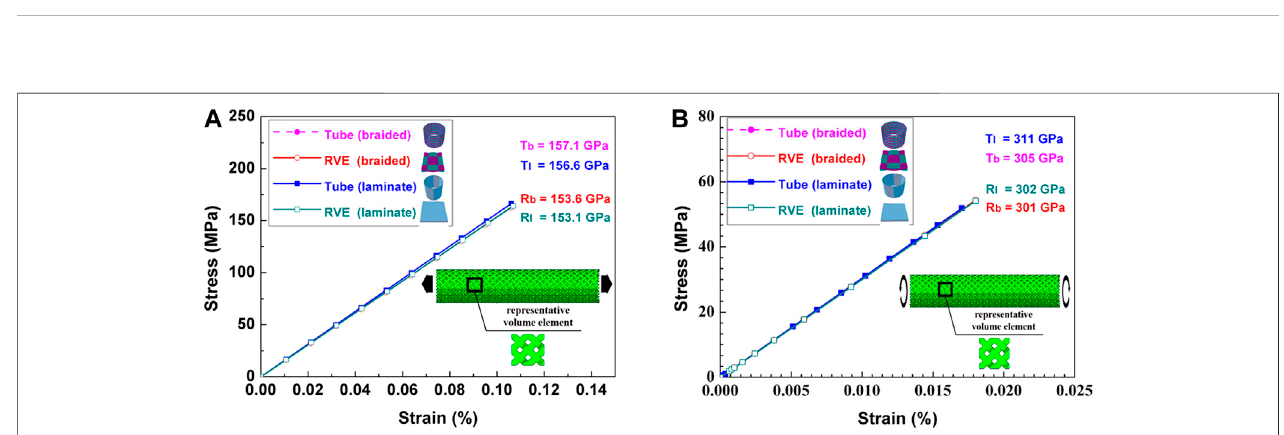
FIGURE 9| The local shear and tensile moduliof thebraided and laminated tubes, validated by unit cell model. (A) The local shear under the global tensile loading; (B) the local tension-compression under the global torsional loading.